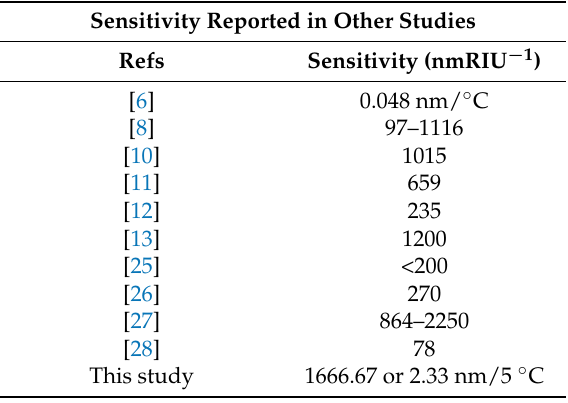
Table 1. The sensitivity reported in the literatures.